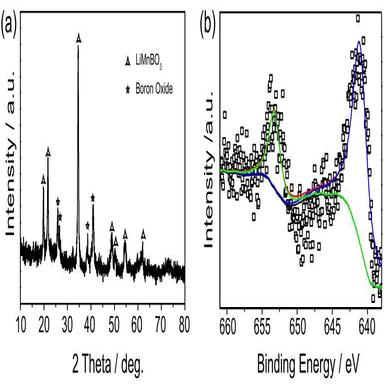
(a) XRD pattern and (b) XPS spectrum of Mn2p3/2 and Mn2p1/2 for LMB/BxOy@C.